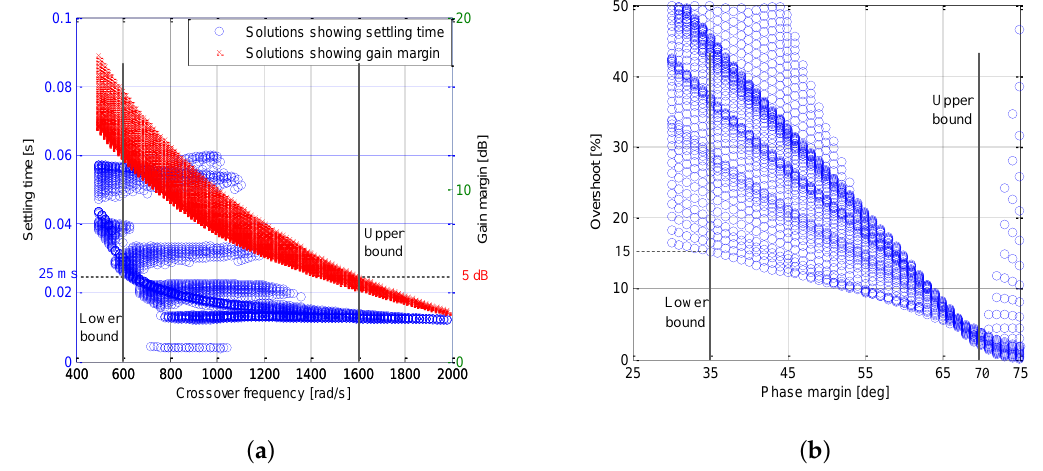
Figure 5. Influence of ω c and φ m on the performance of the system: ( a ) influence of ω c on settling time and gain margin; and ( b ) influence of φ m on